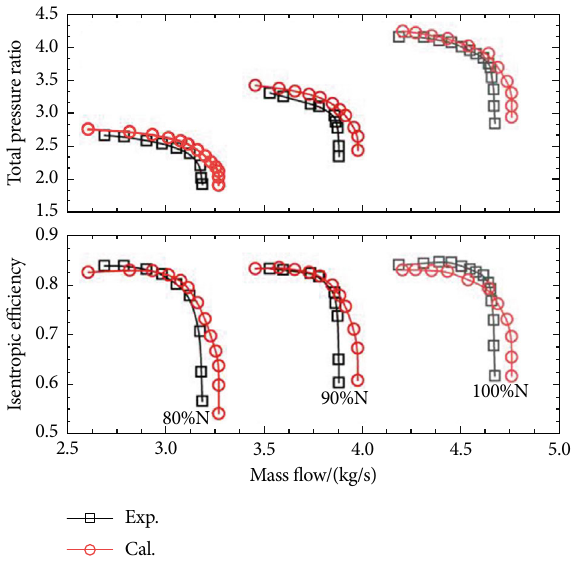
Figure 4: Pressure ratio 4:1 compressor performance at di ff erent rotating speeds [19].